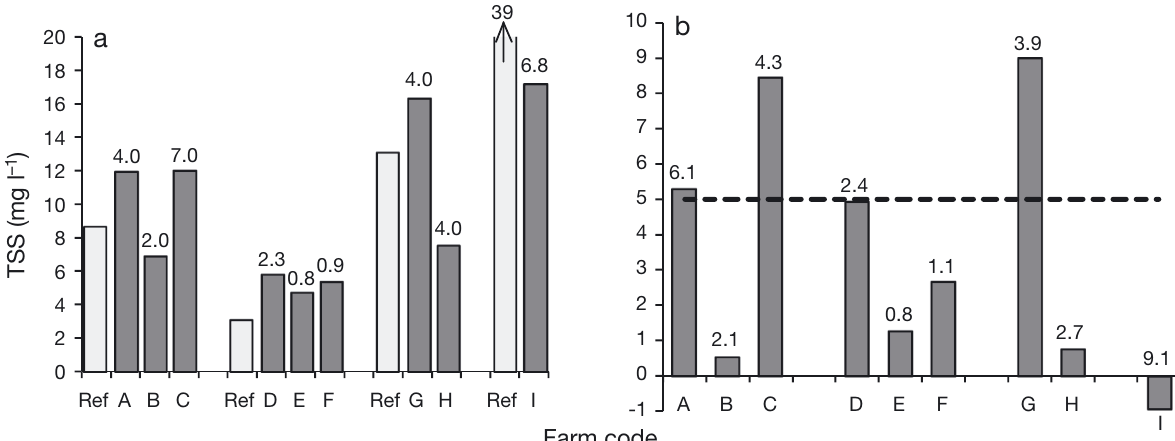
Fig. 3. Median total suspended solid (TSS) concentrations for effluents of south coast (A−F) and west coast abalone farms (G−I). South coast farms are presented separately for Hermanus (A−C) and Gansbaai (D−F). Farm I was operating on partial recirculation. (a) Gross TSS concentrations compared to the 80 th percentile (Ref); (b) concentrations in excess of inflow relative to the 5 mg l −1 standard. The numbers above the dark grey bars are the median absolute deviation. The arrow indicates off-scale reading equal to number above